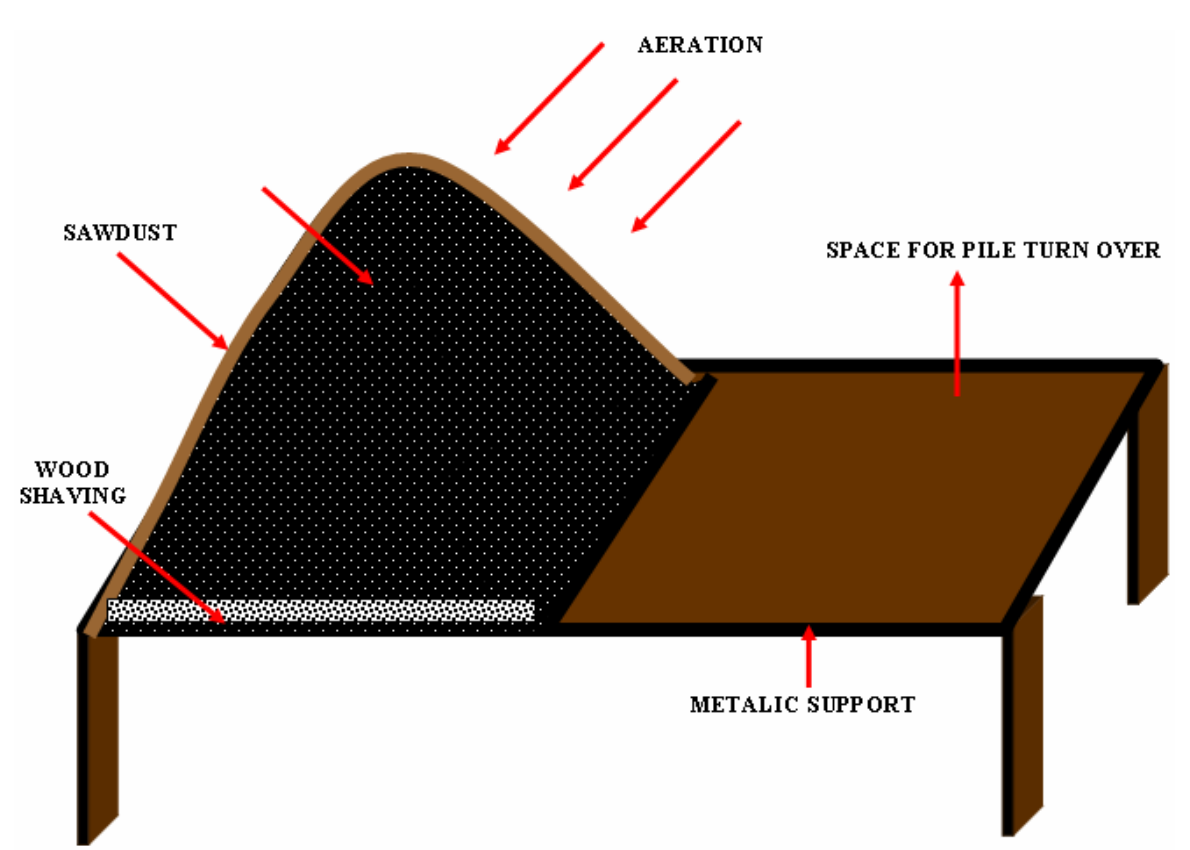
Figure 1: Setup for turning mode of